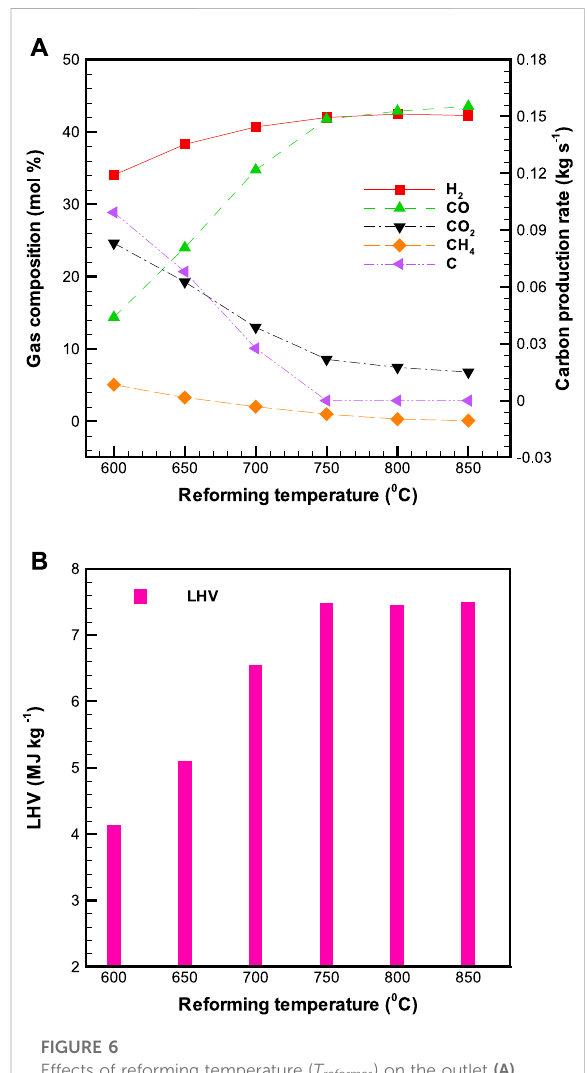
FIGURE 6 Effects of reforming temperature ( T reformer ) on the outlet (A) gas composition, and (B) lower heating value of the product gas in the